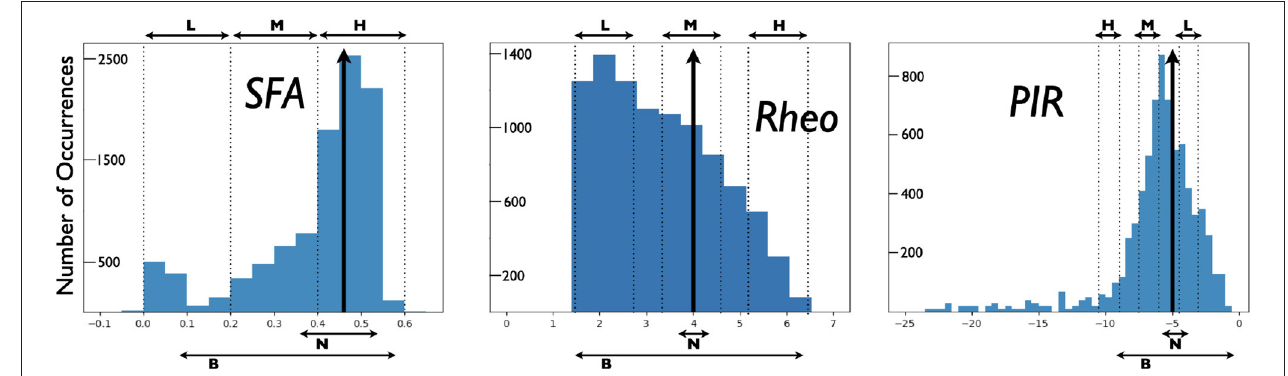
FIGURE 2 | Distributions of PYR cell features from created model database. A heterogeneous set of PYR cells was created and their “building block” features of SFA, Rheo, and PIR were quantified. Details of this quantification are provided in the Supplementary Material . Histograms show the number of occurrences of SFA [=] Hz/pA, Rheo [=] pA, PIR [=] pA values, and vertical black arrows indicate [SFA,Rheo,PIR] base values. Also shown are narrow (N) and broad (B) subsets of heterogeneous PYR cell populations and low (L), medium (M), or high (H) subsets of heterogeneous PYR cell populations that do or do not include base building block values. SFA histogram has a bin resolution of 0.05, and Rheo, PIR histograms have a bin resolution of